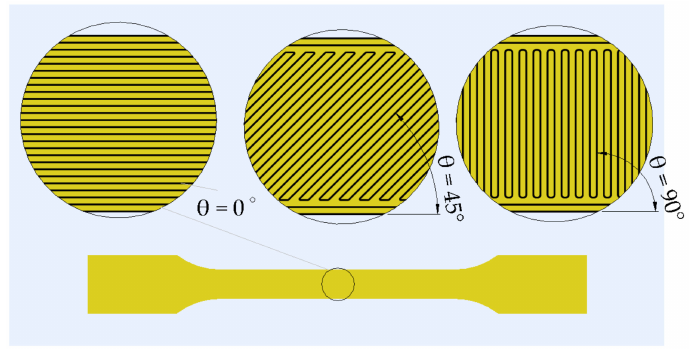
Figure 3. Raster angle ( θ ).